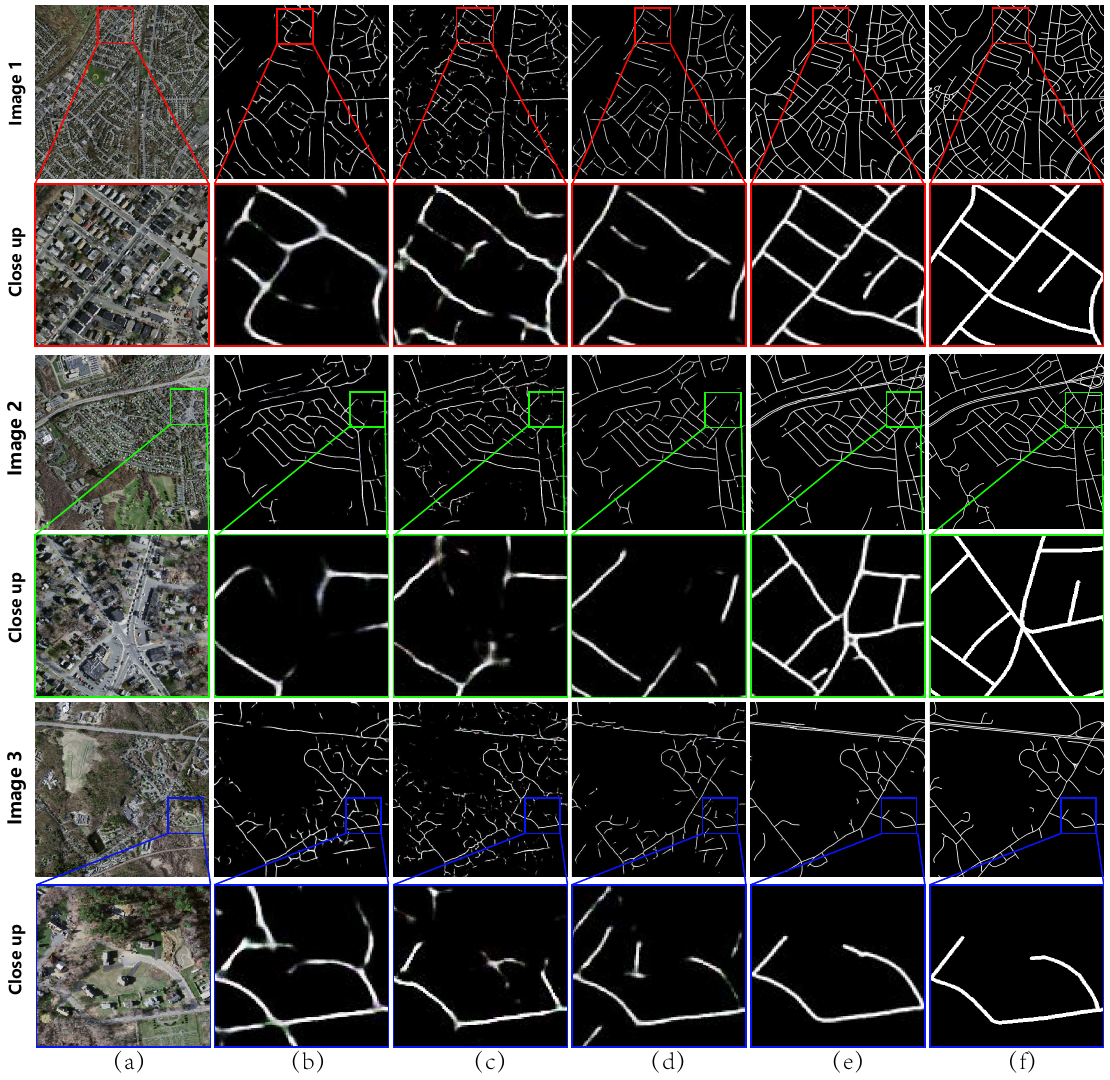
Figure 3. Typical comparison on parameters: ( a ) original image; ( b ) result of the method in [3] (the initial road network); ( c ) result without L VGG ; ( d ) result without L r ; ( e ) result of McGAN; and ( f ) result of the reference map. The red boxes in ( b – d ) indicate some poor extraction parts compared with ( e